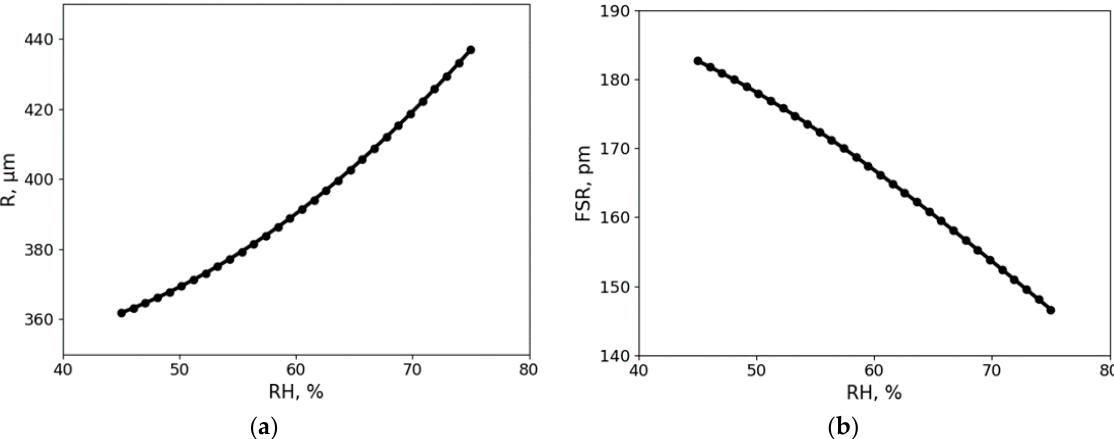
Figure 8. ( a ) The radius of the glycerol droplet at different RH levels. The curve illustrates the theoretically obtained values; ( b ) The resonator’s FSR at different RH levels also calculated theoretically.